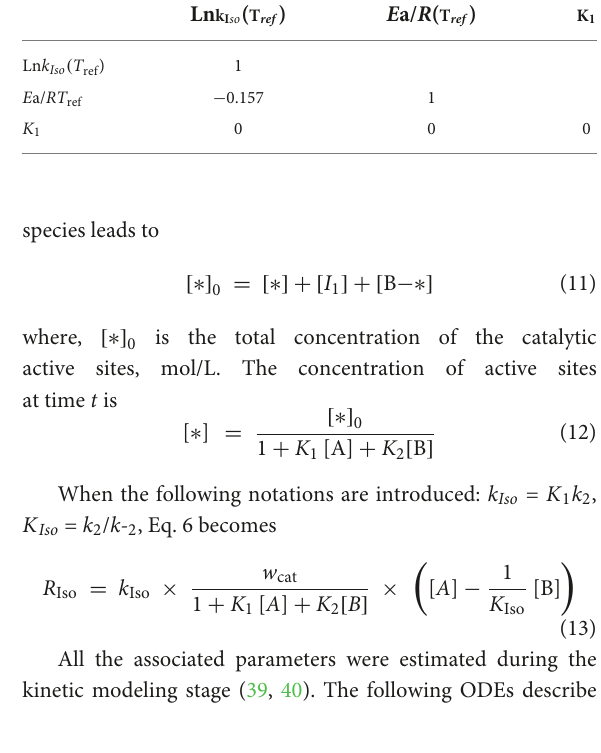
TABLE 3 Estimated and statistical data at T ref = 353 . 15 K for sesamin conversion.